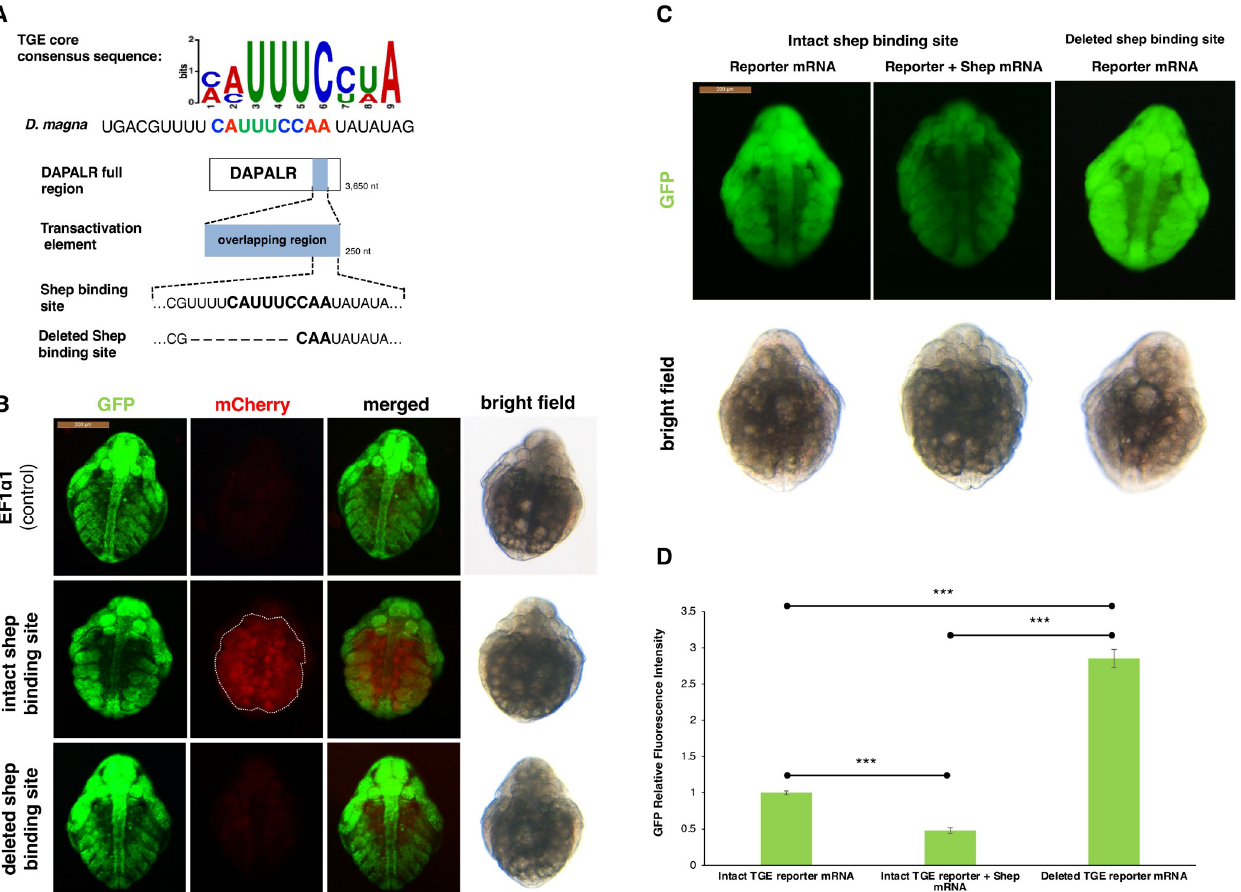
Fig 5. Dsx1 post-transcription regulation by DAPALR and Shep in vivo . (A) Shep binding site consensus sequence and its similarity with TGE core consensus sequence. Position of the potential binding site was also shown located at the 3´end of the transactivation element of DAPALR . Sequence of the mutated Shep binding site used for the experiment was also shown. (B) Ventral view of female embryos of Dsx1 reporter strain injected with control plasmid, plasmid expressing intact TGE and plasmid expressing deleted TGE. mCherry fluorescence allowed visualization of Dsx1 expression while GFP fluorescence in the nucleus enabled observation of body structures. The merged images of mCherry and GFP and the bright field images were used to understand the localization pattern of mCherry expression. dotted lines: yolk area. (C) Ventral view of female embryos of wildtype strain injected with Dsx1 5 0 UTR-GFP reporter mRNA and reporter mRNA plus Shep mRNA and Dsx1 5 0 UTR without TGE-GFP reporter mRNA observed at 30 h after injection. GFP fluorescence signals showed efficiency of translation. The bright field images were used to understand the localization pattern of GFP expression. (D) Relative GFP fluorescence intensity calculated among three treatments. Error bars indicate the standard error of the mean, n = 5. The end points of the line above the bars show which samples were compared statistically. ��� p < 0.001(Student’s T-test).